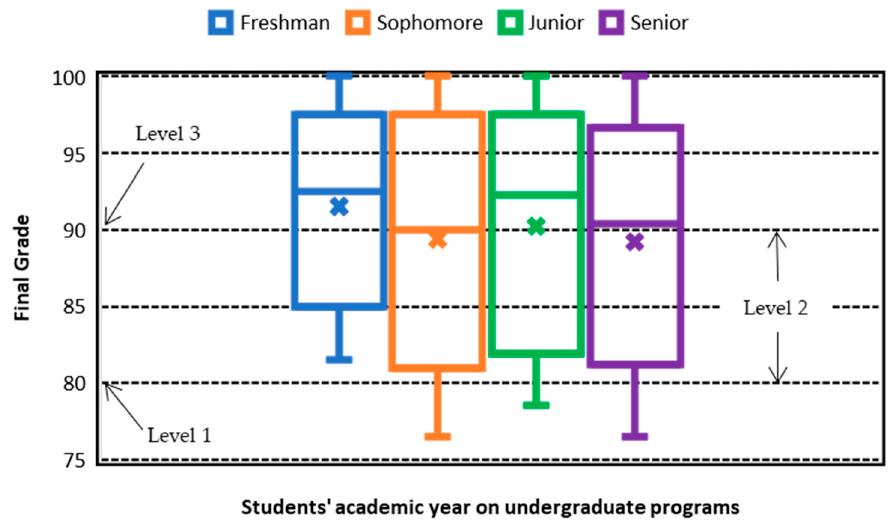
Figure 10. Box and whisker plot on the final grade vs. undergraduate year for the EFR competency.